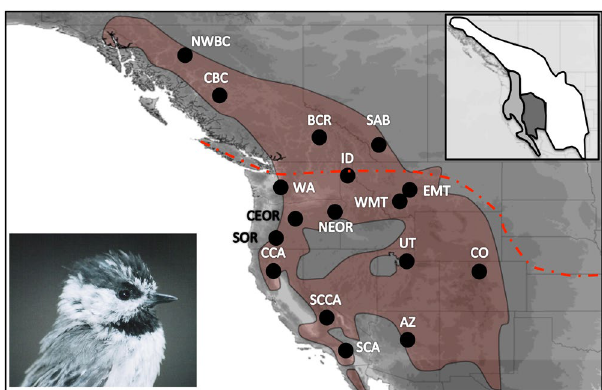
Figure 1. Range map showing the sampling sites for mountain chickadees (lower inset; picture taken by Brendan Graham) in western North America. The red dashed line indicates the extent of glaciation during the Last Glacial Maximum. Top right inset shows three major morphological groups previously described in Behle 69 : gambeli – white, inyoensis – dark grey, baileyae – light grey. Sampling sites include central British Columbia (CBC), northwest BC (NWBC), Revelstoke, BC (BCR), southern Alberta (SAB), western Montana (WMT), eastern Montana (EMT), Colorado (CO), Utah (UT), Arizona (AZ), Washington (WA), Idaho (ID), northeast Oregon (NEOR), central OR (CeOR), southern Oregon (SOR), central California (CCA), south central CA (SCCA), and southern CA (SCA). Range maps were created in DIVA-GIS 7.5 (www.diva-gis.org) using digital distribution files provided by Ridgley et al . 70